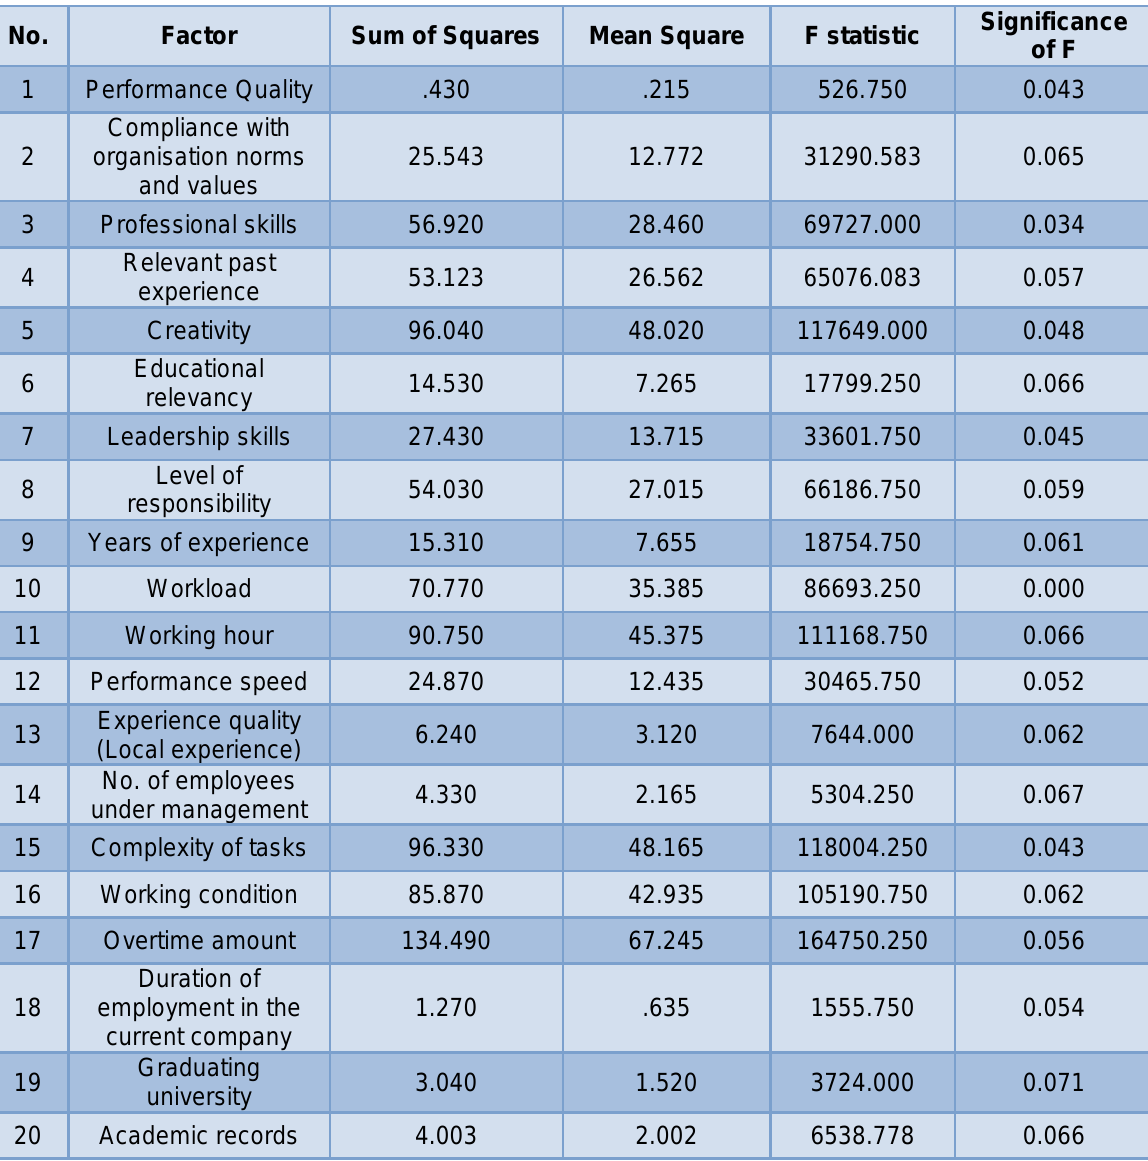
Table 5 ANOVA analysis results: significantly different factors by participating groups (Sig<0.05